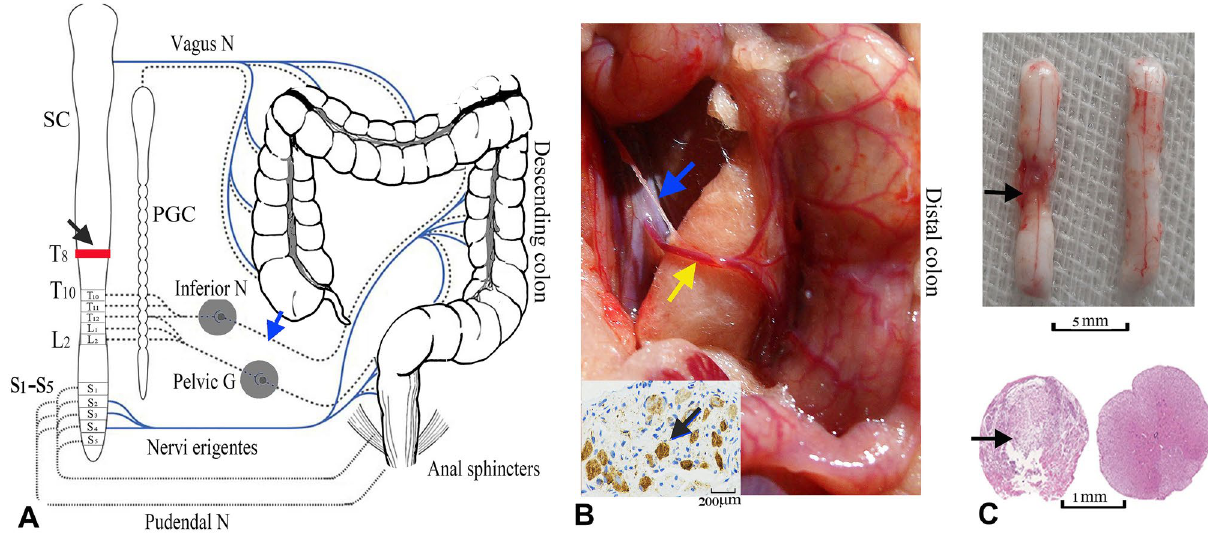
Figure 1. Surgery of SCI model and PSIMA. ( A ) Design of PSIMA for humans (the anatomy of colon), the sympathetic innervation (T10-L2) and parasympathetic innervation (S2–S4) are showed by dashed lines and blue lines, respectively. The blue arrow indicates the site of the nerve cut, and the black arrow indicates the level of the SCI. ( B ) The anatomy of accompanying sympathetic plexus and inferior mesenteric artery in a rat. The inferior mesenteric artery (indicated by yellow arrow), which originates from the anterior wall of the bifurcation of the left and right common iliac arteries, is mainly divided into the upper, middle, and lower branches, and with its accompanying sympathetic plexus (indicated by blue arrow) is situated to the distal colon. Lower left panel, an excised sympathetic nerve specimen stained with TH staining. ( C ) The upper panel showed the damaged segment of the spinal cord, four weeks after SCI (left) with the normal control (right), the lower panel, HE staining under the optical microscope, showed a complete damage at a cross section of the damaged segment. SC (spinal cord), PGC (paravertebral ganglia chain), Inferior N (inferior mesenteric ganglia), Pelvic G (pelvic ganglion), Vagus G (vagus ganglion), Pudendal G (pudendal ganglion), T8 and T10 (the 8th and 10th thoracic levels of the spinal cord), L2 (the second lumbar level of the spinal